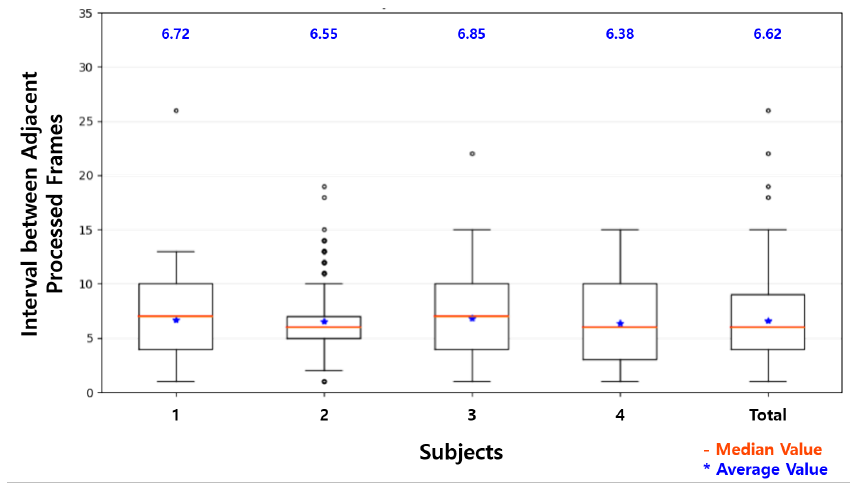
Figure 15. Interval distribution on the proposed